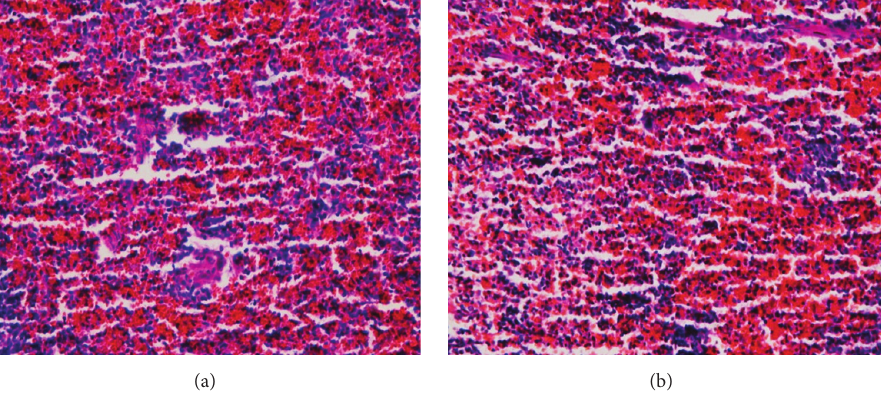
Figure 5: (a) Treated spleen. (b) Control